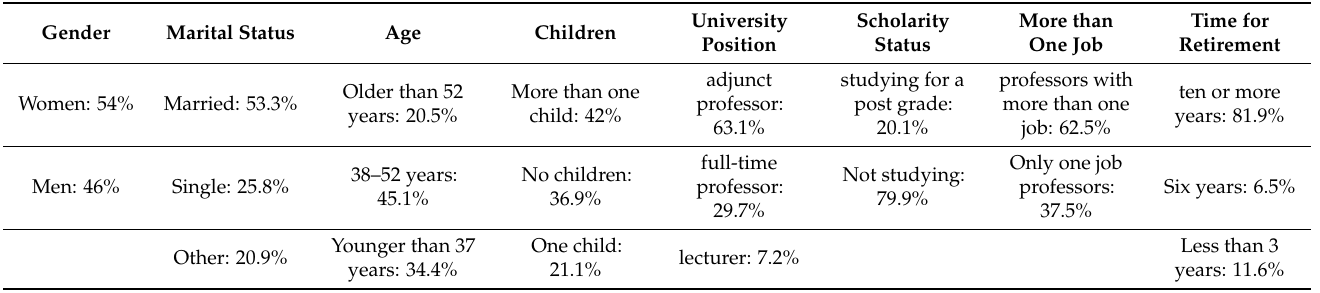
Table 2. Demographics of the participants/Faculty members.